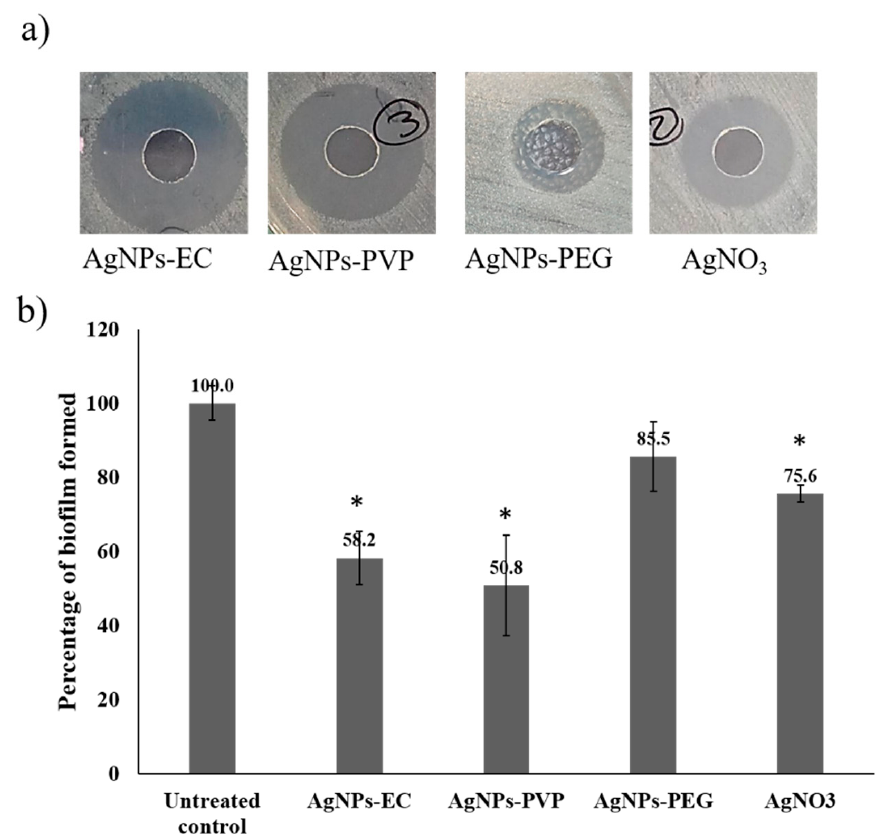
Figure 3. Antibacterial and antibiofilm activities of the differently prepared AgNPs-stabilized polymers and silver nitrate solution. ( a ) Inhibition zone diameters induced by the formulations and ( b ) biofilm formation in the presence of different tested samples. Columns show the mean values of 3 experiments ± S.D. * Denotes a p -value < 0.05 as tested by unpaired t -test compared with the untreated control samples.